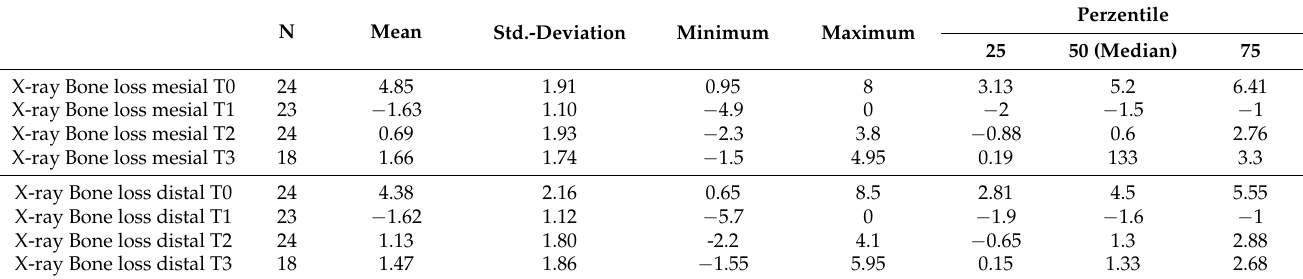
Figure 3. Bone level changes at the assessed time points. “ ◦ ” = outlier. Absolute numbers are expressed in Table 3. The negative values at T1 represent the over-augmentation, which was performed as described. Table 3. Bone level changes from T0 to T3.